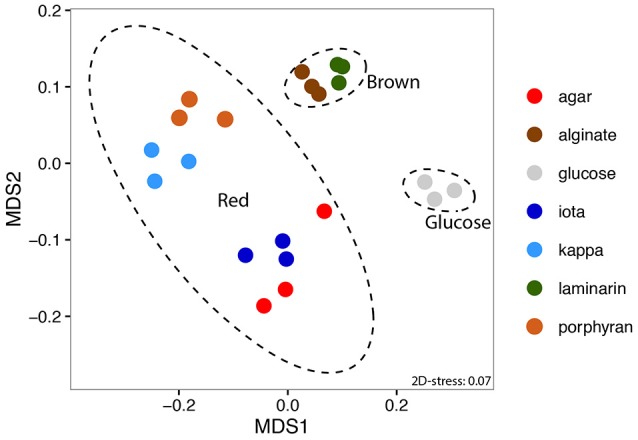
Non-metric Multi-Dimensional Scaling (NMDS) ordination of expression data based on Morisita-Horn dissimilarity. 95% confidence ellipses are depicted for the three groups of substrates (glucose, brown or red algal polysaccharides).